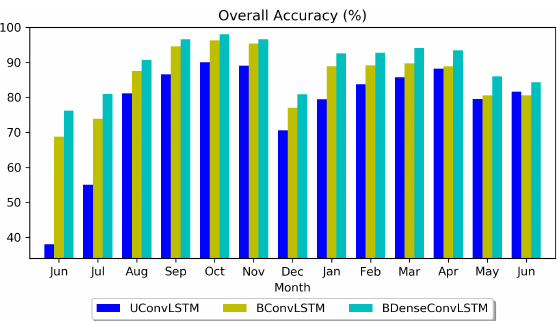
Figure 10. Average F1-Score for LEM study area, computed in each